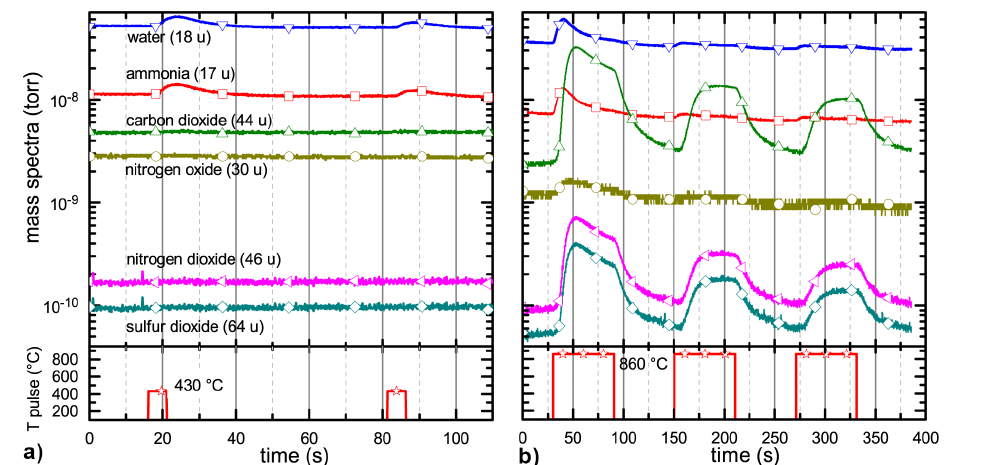
Figure 5. Mass spectra of ammonia-contaminated fly ash (84mgkg − 1 ) when heating up the ash to 430 ◦ C (a) and 860 ◦ C (b) . Carrier gas is dry synthetic air.